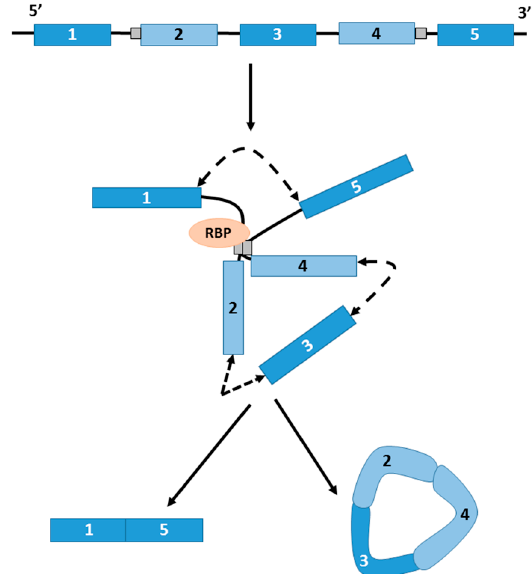
Figure 1. The biogenesis of circular RNA (circRNA). The linear primary transcript contains exons (blue boxes), introns (black lines), and possibly repetitive elements or sequence motifs (grey boxes). Circular exons are generated from back-splicing events between the splice donor site of a downstream exon and the splice acceptor site of an upstream exon. This can be mediated by specific sequence elements (grey boxes) or by interaction with RNA binding proteins (RBPs). Splicing events are indicated by dashed lines with double arrowheads. This may result in the production of a circular RNA and a linear RNA which lacks the circularised exons.